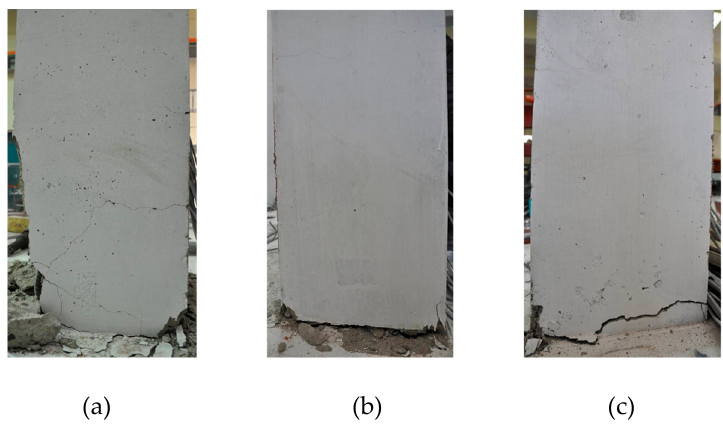
Figure 10. Damages and failure patterns of three column specimens: ( a ) RC-0; ( b ) RSH-s; ( c ) RSH-